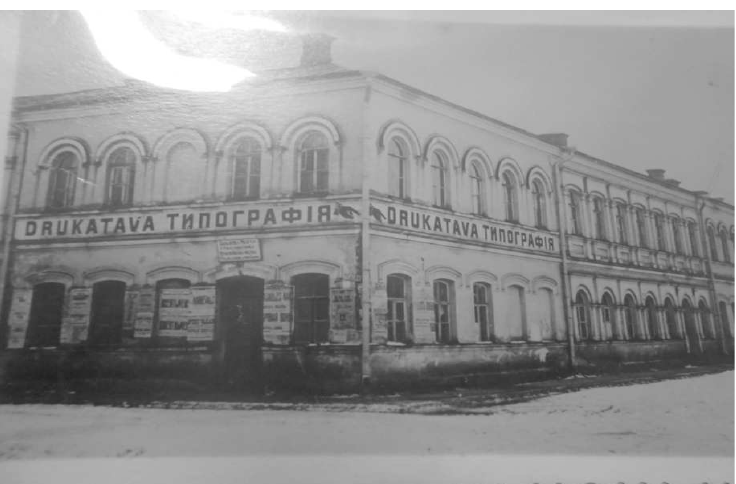
Fig. 1. Language signs of